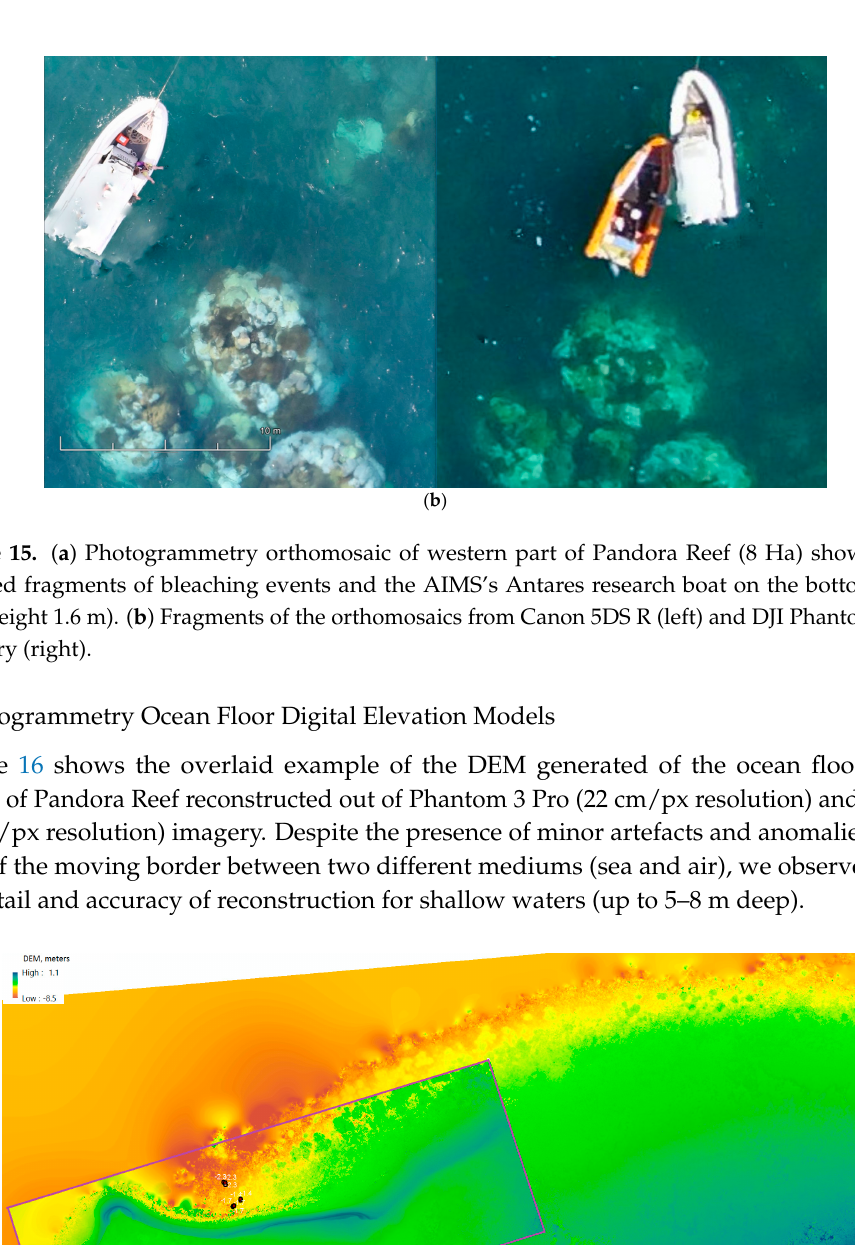
Figure 16. Digital elevation model (DEM) of Pandora Reef generated from Phantom 3 Pro and Canon 5DS R (purple area) and in-water survey depths (black dots).